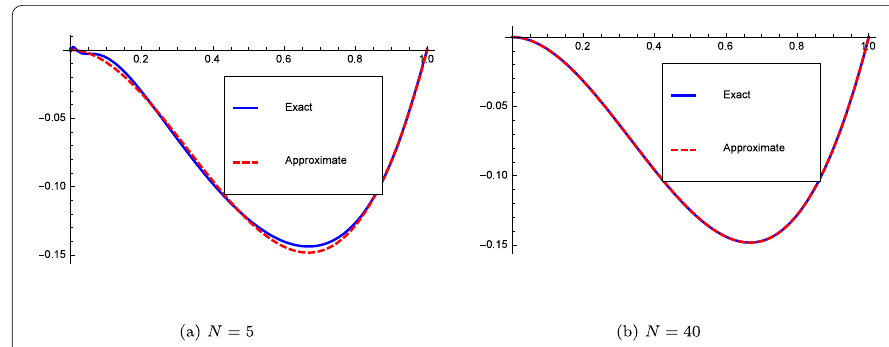
Figure 3 Graphs of exact and approximate solutions for u in Example 2.